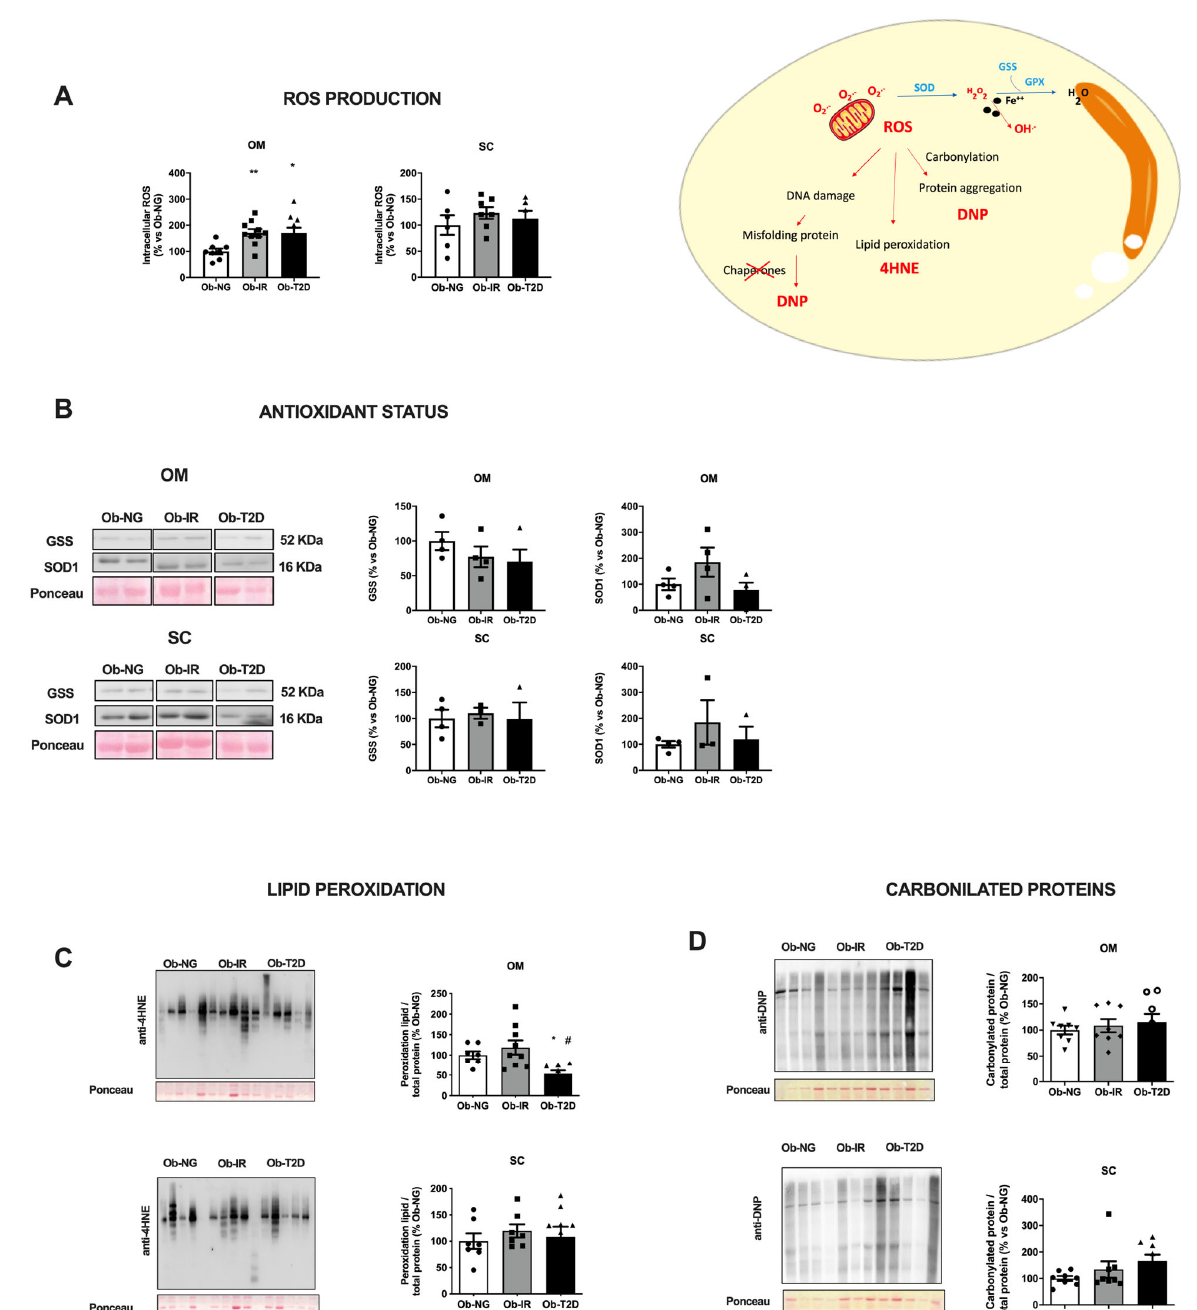
Figure 1. Analysis of the redox status of specific human adipose tissue depots. ( A ) Intracellular ROS in extract from omental (OM) and subcutaneous (SC) human adipose tissue in obese normoglycemic (Ob-NG), insulin resistance (Ob-IR), or diabetic (Ob-T2D) subjects. ( B ) GSS and SOD1 protein expression (immunoreactive bands) in extracts from OM and SC depots; for quantification, protein levels were normalized using Ponceau staining. ( C , D ) Quantification of carbonylated proteins using 4-HNE-modified proteins ( C ) and DNP-protein adducts ( D ) in OM and SC human adipose tissue. Immunoblot images (left panel) and quantification (right panel) are shown. Data represent the mean ± SEM (n = 4–6 samples/group). Individual data from different group has been represented by circle (Ob-NG), square (Ob-IR) or triangle (Ob-T2D) * p < 0.05; ** p < 0.01 vs. Ob-NG; # p < 0.05; vs. Ob-IR using One-way ANOVA for parametric data, or Kruskal–Wallis test, for nonparametric data, as posthoc